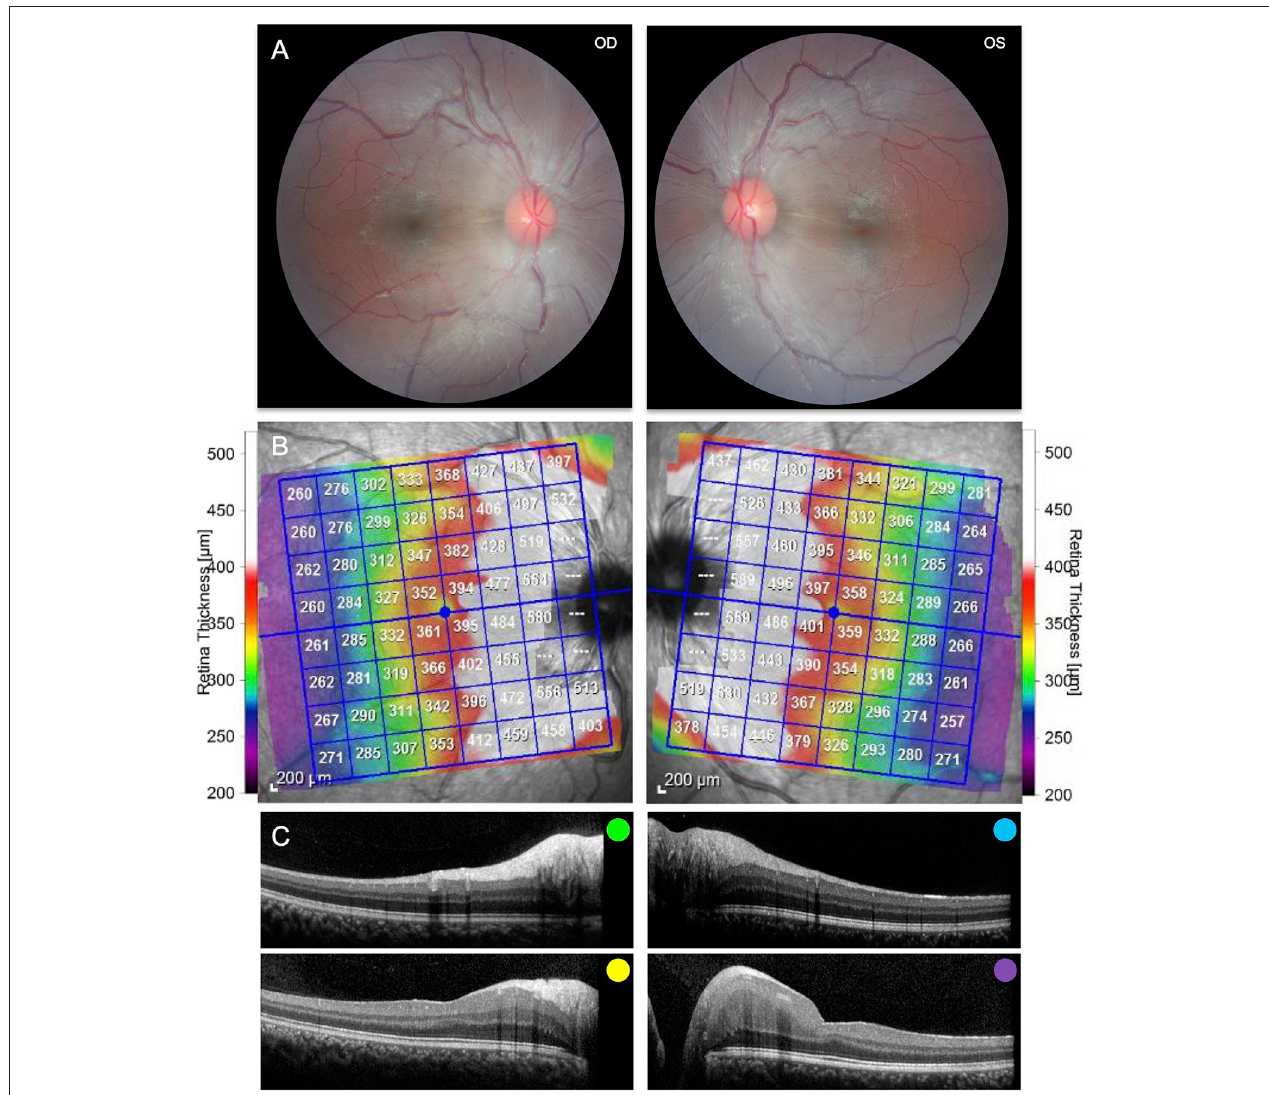
FIGURE 2 | (A) Fundus photography of the right and left eyes demonstrating peripapillary retinal nerve fiber hypertrophy and white striations emanating adjacent to the optic nerve. (B) Posterior pole Optical Coherence Tomography demonstrating hypertrophy of the retinal nerve fiber layer and other inner retinal layers. (C) Selected cross sections of the right and left eye demonstrating hypertrophy of the retinal nerve fiber layer and other inner retinal layers. Colors correspond to the retinal layers depicted